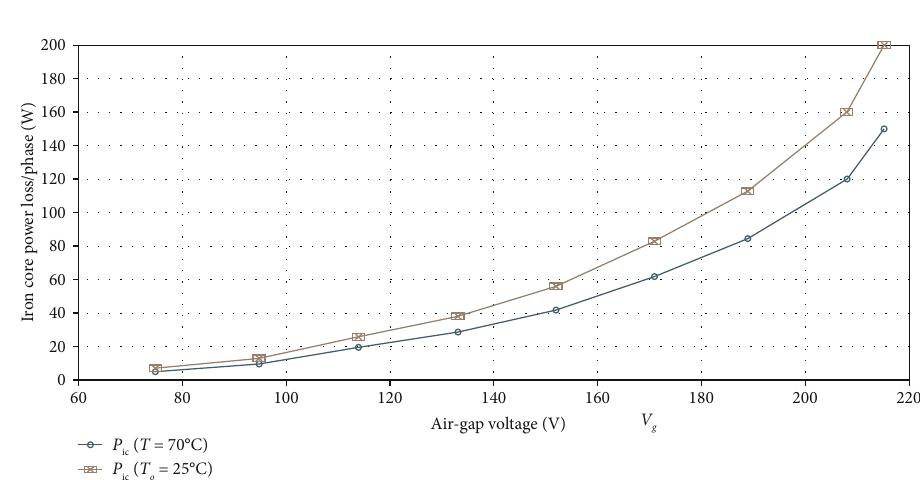
Figure 5: Variation of air-gap voltage with iron core power loss with and without temperature e ff